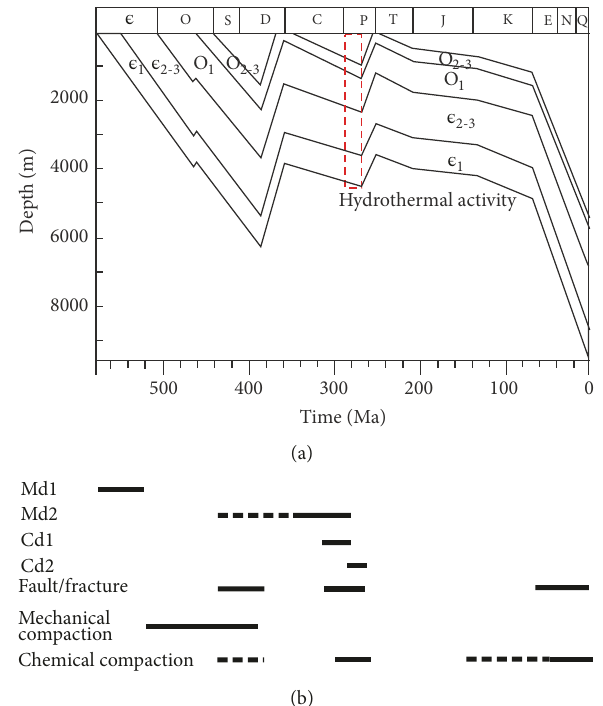
Figure 4: (a) Burial history curves of the Cambrian and Ordovician strata from well TS1 in the North Uplift (modified from Zhu et al., 2015). Dashed rectangle denotes the periods of Early Permian hydrothermal activity, based on data from [5, 26, 27]. (b) Paragenetic sequence of the main diagenetic events of Cambrian strata in the studied well. Dashed lines indicate uncertain timing or a long-term event.